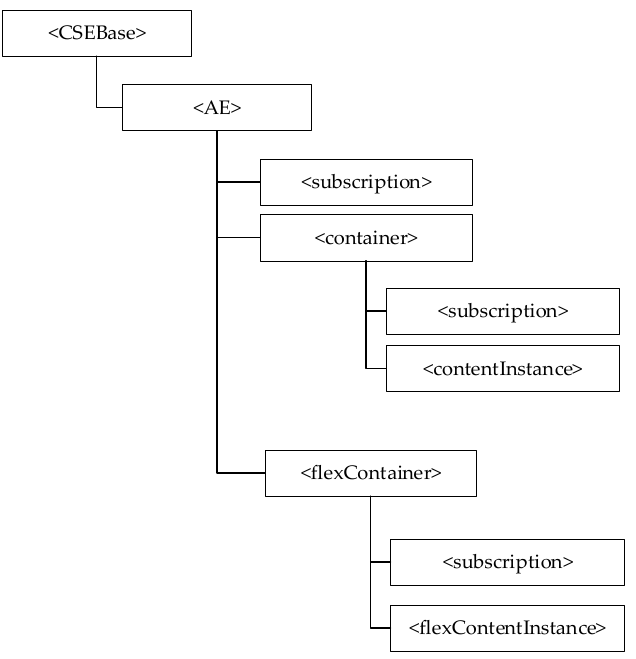
Figure 5. Common Service Entity (CSE) resource tree.